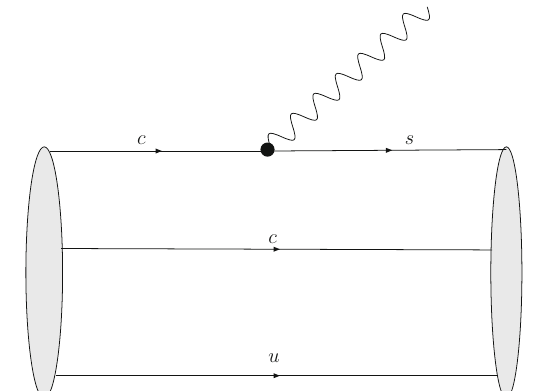
Fig. 1 The Feynman diagram for (cid:2) cc → (cid:2) c transitions, where • denotes V − A current vertex of | (cid:2) cc ( P , S , S z ) (cid:4) and | (cid:2) tem stands as a spectator, i.e. its spin configuration does not change during the transition, so the transition matrix element can be divided into two parts: